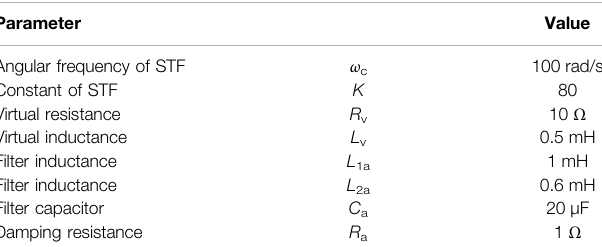
TABLE 2 | Parameters of active